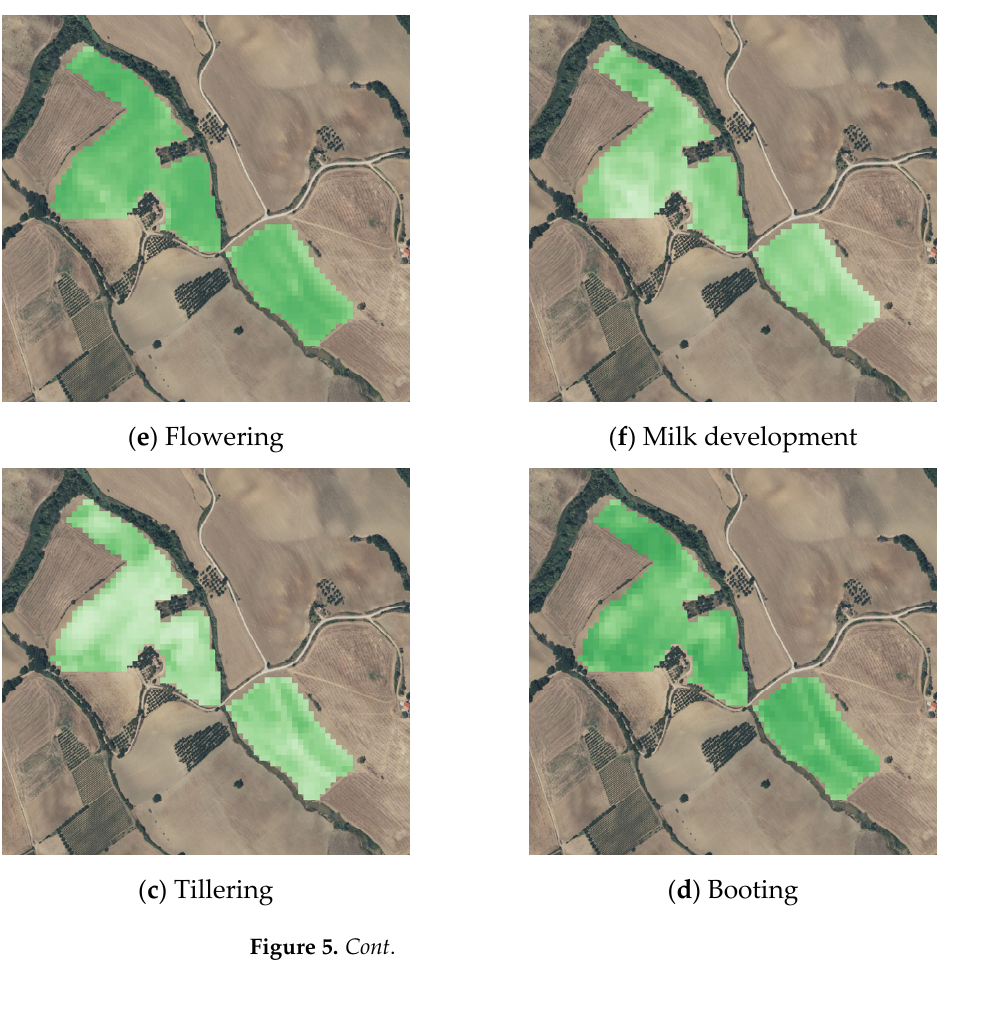
Figure 4. Box plot of NDVI data collected at germination, seedling, tillering, booting, flowering, and milk development growth stages. The minimum, maximum, first quartile (Q1 or 25 th percentile), third quartile (Q3 or 75 th percentile), and median values are reported. Values that lie in both ex- tremes of data were reported as points (outliers).